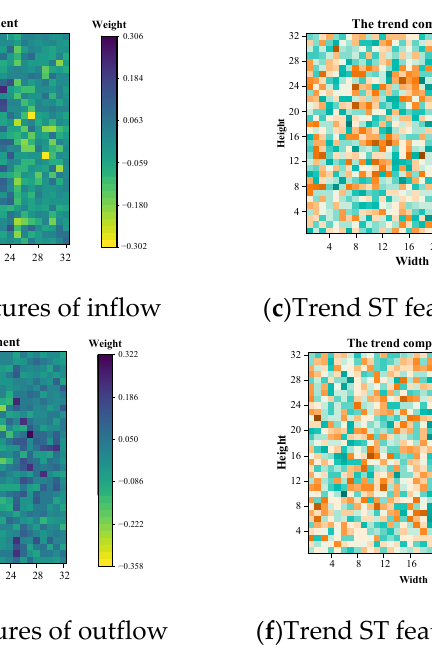
Figure 11. Visualization of MFR module for TaxiBJ dataset.